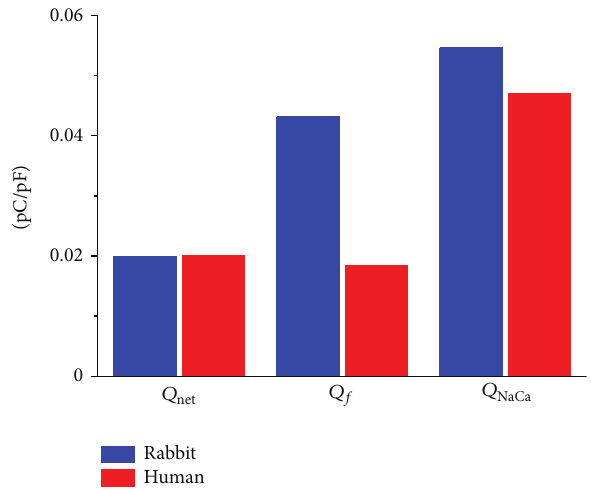
Figure 4: Charge carried by net membrane current ( 𝑄 structed hyperpolarization-activated inward current ( 𝑄 𝑓 ), and reconstructed sodium-calcium exchange current ( 𝑄 20 mV spontaneous depolarization from MDP + 1 mV of the rabbit and human SA nodal action potentials of Figure